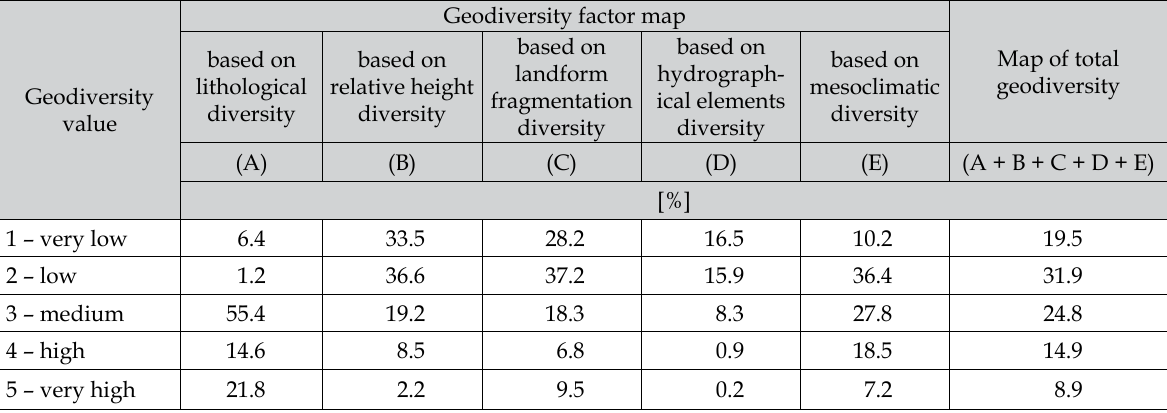
table 3. the percentage of diversified areas in terms of geodiversity values based on: lithological diversity (A), relative height diversity (B), landform fragmentation diversity (C), hydrographical elements diversity